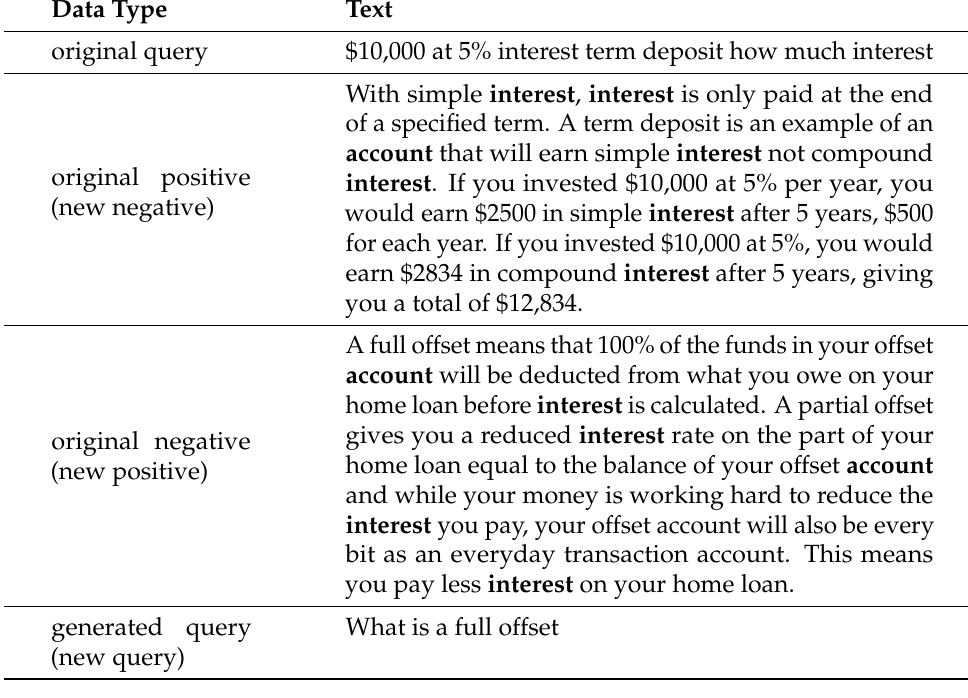
Table 7. Data Augmentation Case. In this case, since there are lots of overlapping tokens ( ‘interest’ , ‘account’ , which are in bold type) between the original positive and negative, it is hard for the model to judge whether the positive and negative are similar through term frequency. We calculate the similarity between the generated query and the original query, and the similarity score is lower than 0.1 (using cosine similarity), so we regard the original positive as the negative of the generated query and build a new